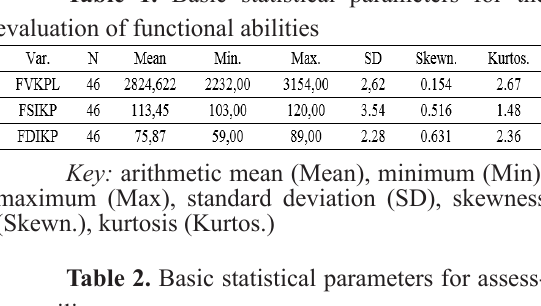
Table 4. The structure of statistically significant canonical factor in the system of functional variables